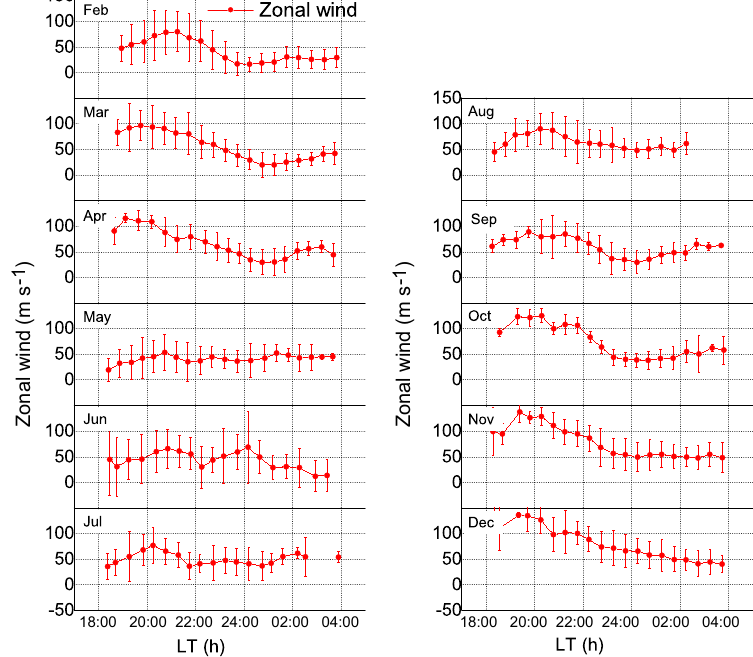
Figure 5. Monthly average of the zonal component of thermospheric neutral wind. Positive values are eastward. LT is UT − 3.